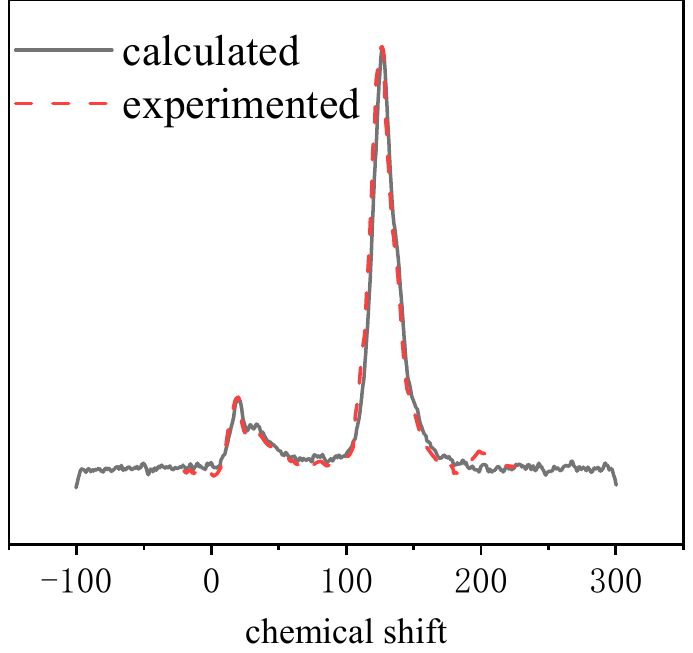
Figure 6. Experimental and calculated 13 C-NMR spectra.